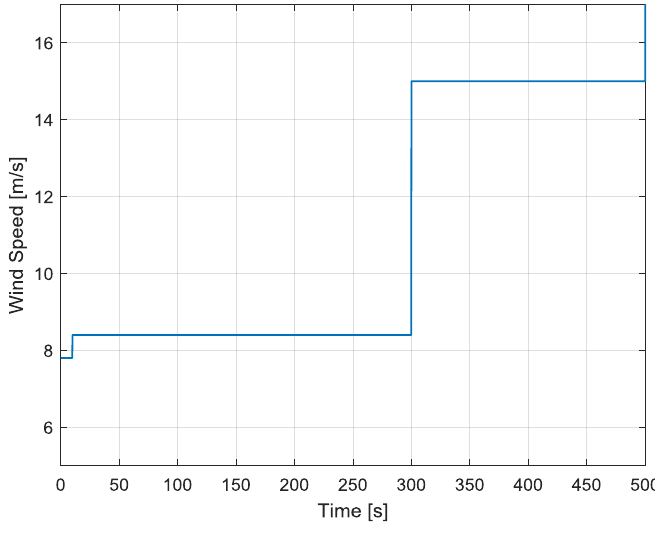
Figure 17. Wind speed time profile.